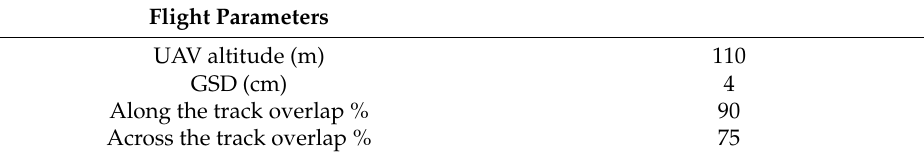
Table 2. Parameters of UAV flights.